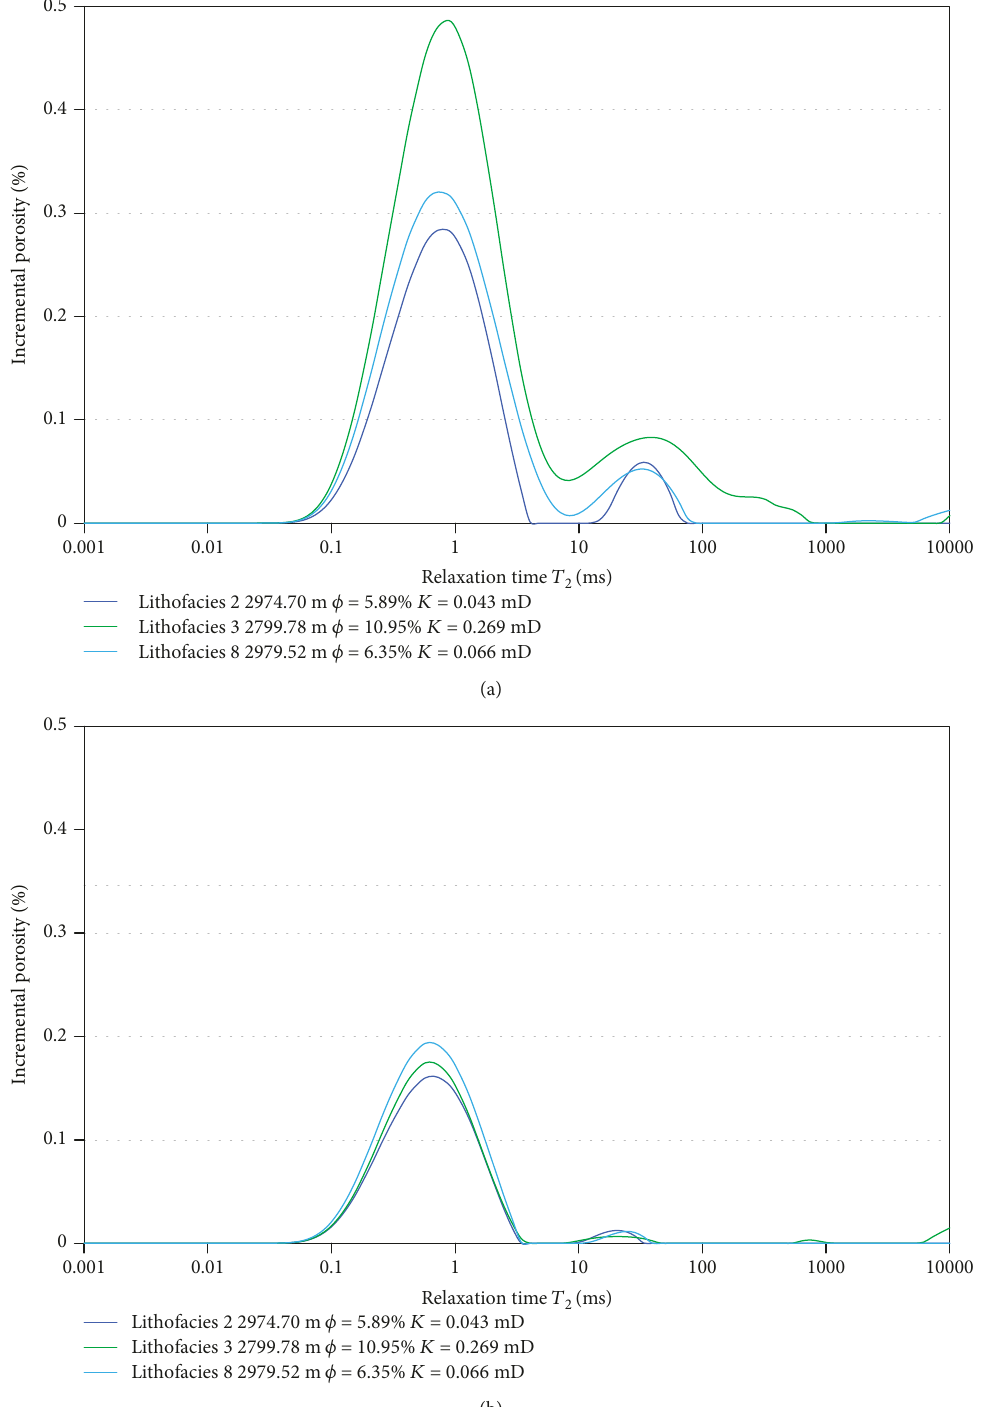
incremental spectra: (a) 100% saturated, showing bimodal behaviours, and (b) centrifuged, showing unimodal 2